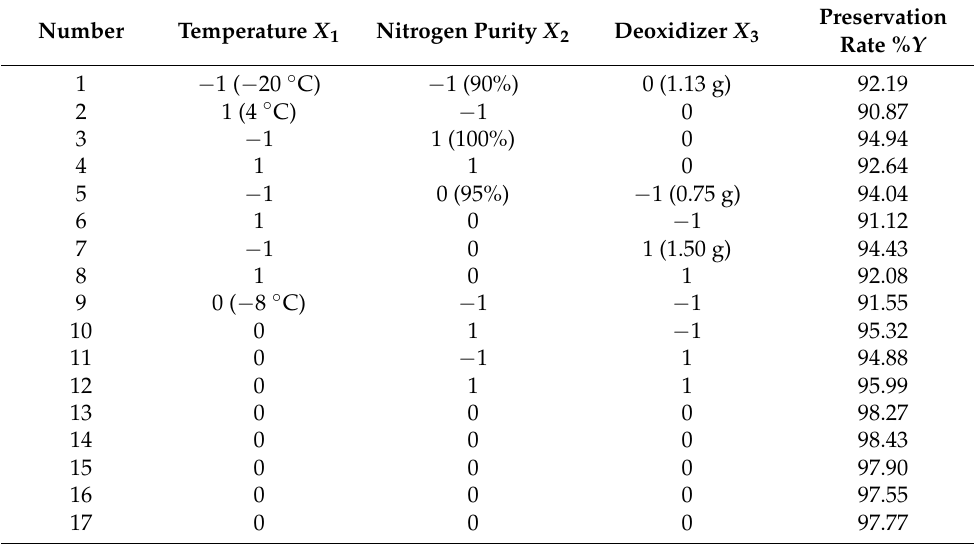
Table 3. Results of Box–Behnken response surface